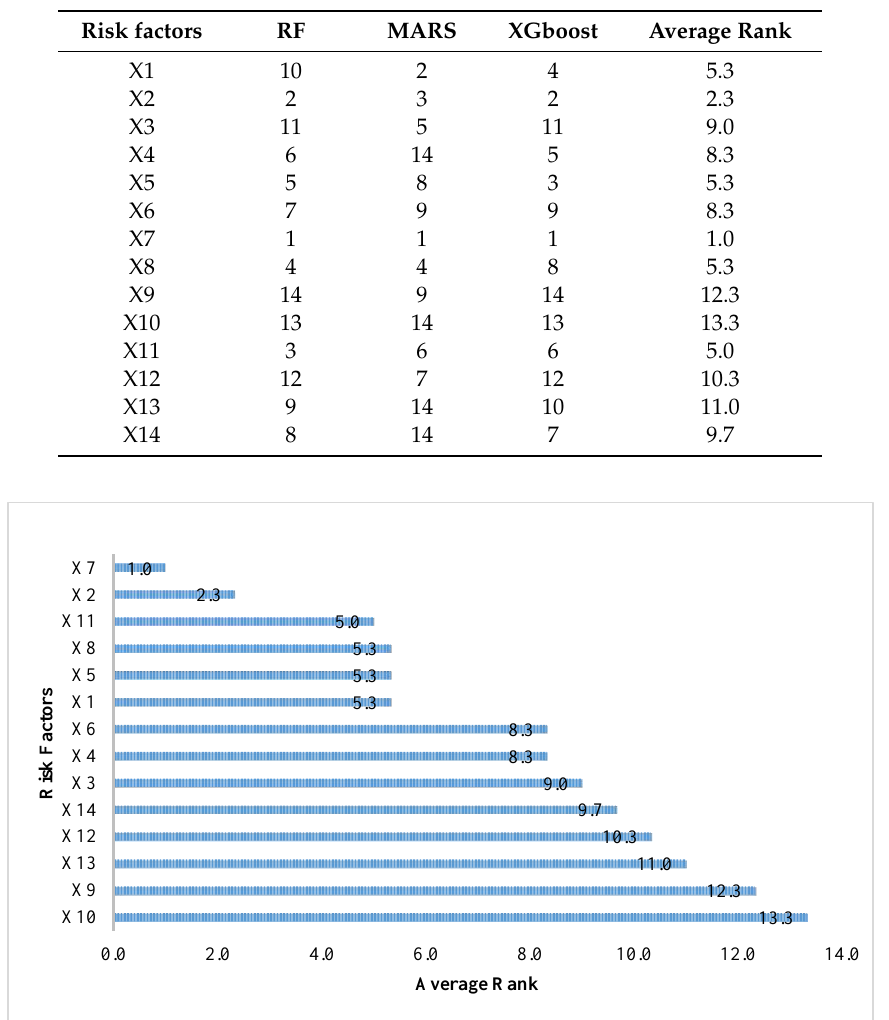
Table 2. The selected and ranked risk factors using the RF, MARS, and XGboost methods.